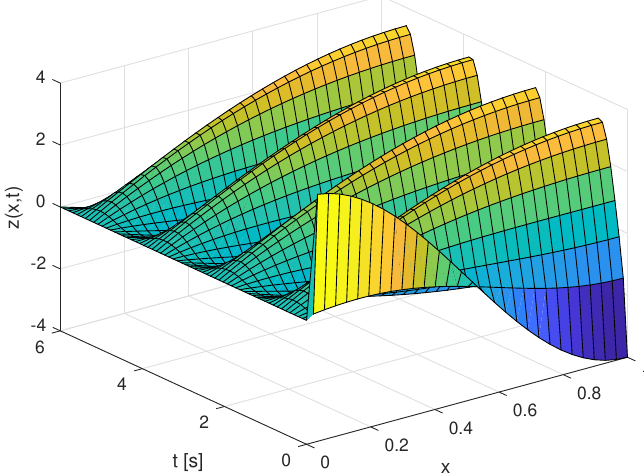
Figure 4. Plot of the solution surface for λ = 2.5.